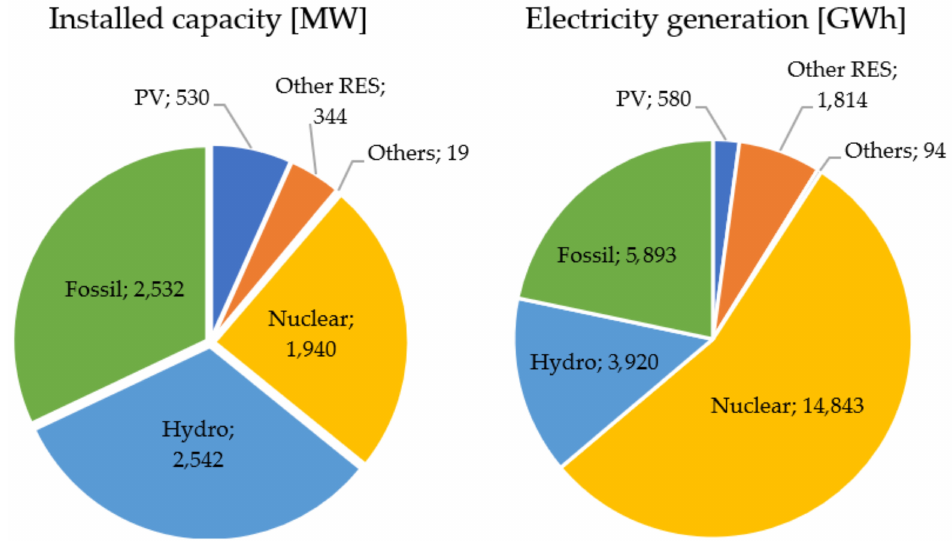
Figure 7. Structure of Slovak installed capacity and electricity generation in 2019